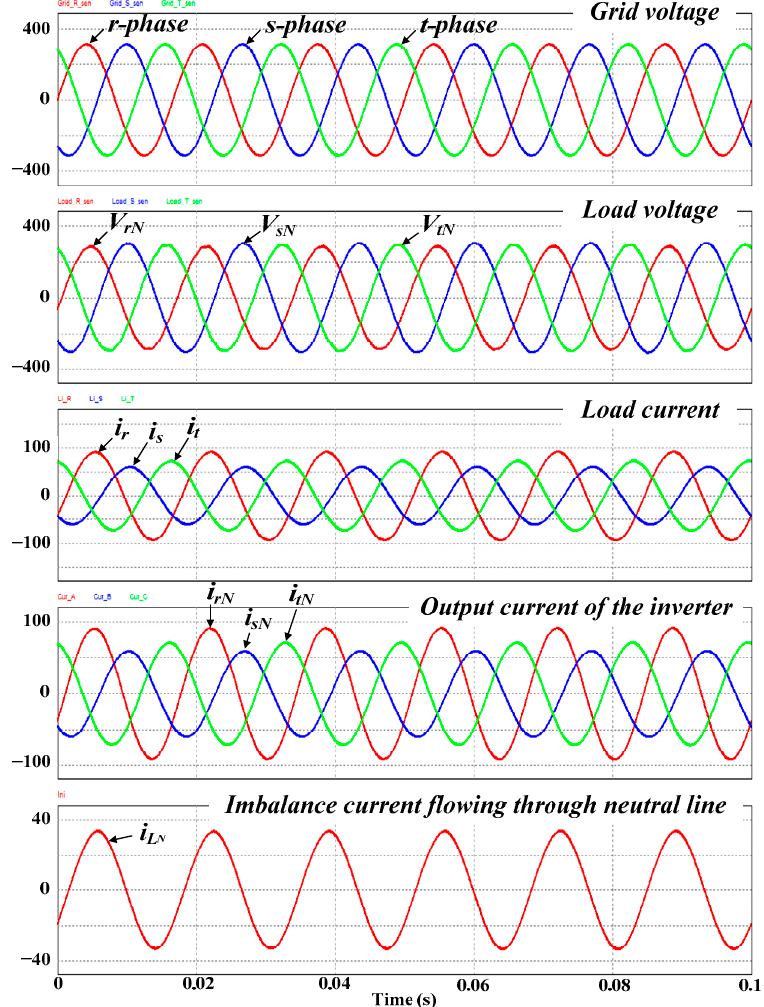
Figure 10. Simulation results of imbalance voltage compensation using the offset voltage for split dc-link capacitor 3-leg inverter in the independent operation mode.